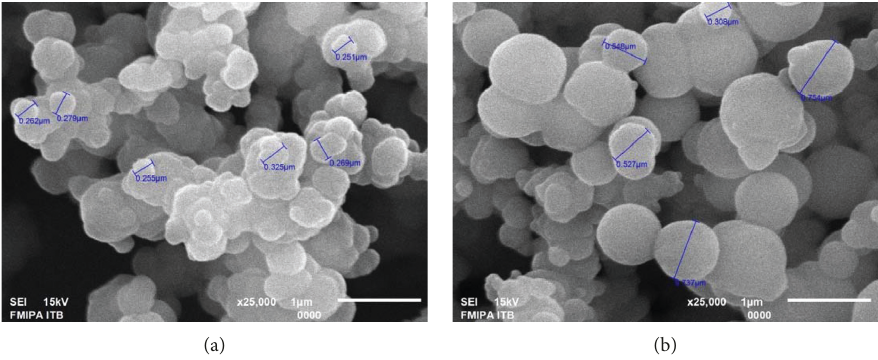
Figure 6: SEM images of (a) MIP by precipitation polymerization and (b) NIP by precipitation